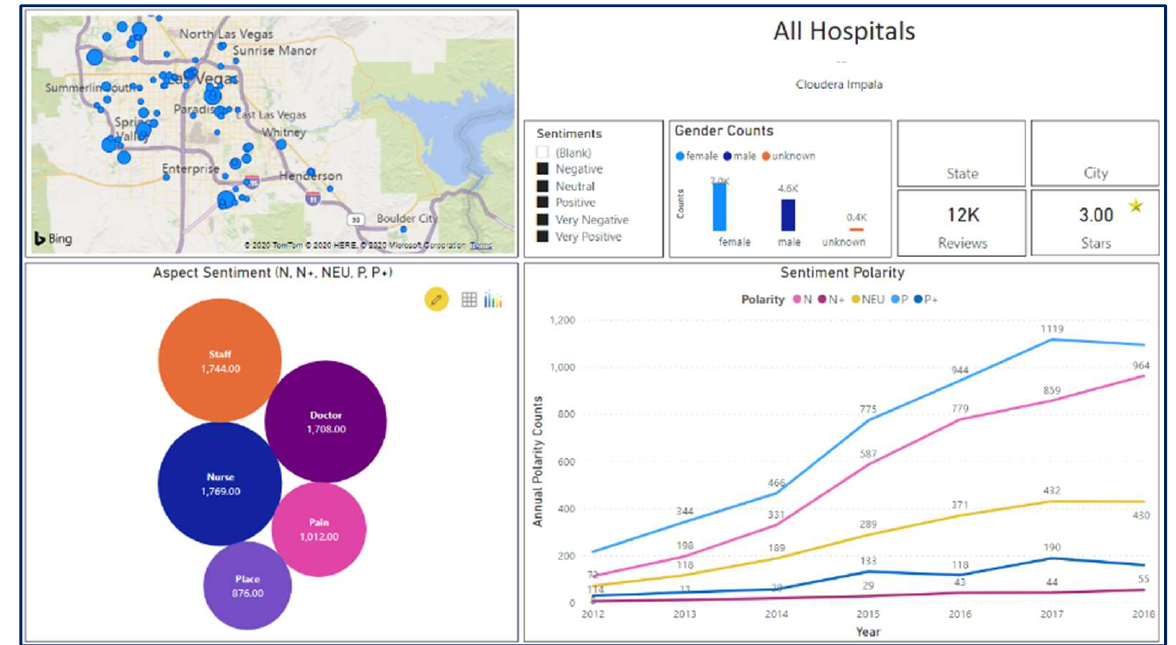
Figure 10. Main VoP dashboard. Smart Cities 2021, 4, FOR PEER REVIEW